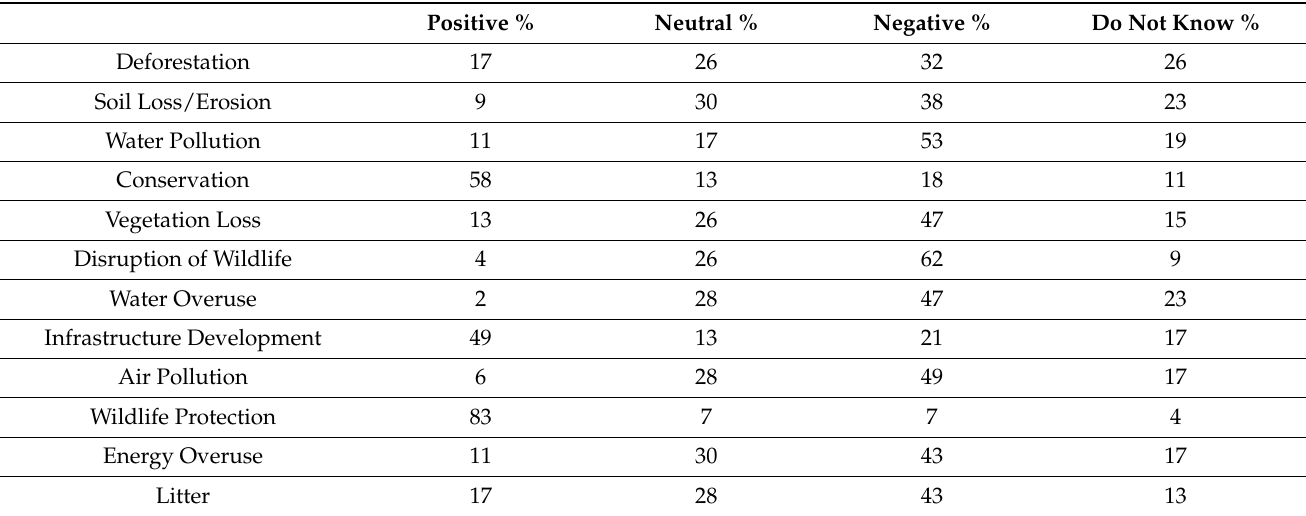
Table 1. Tourist perception of how tourism impacts the